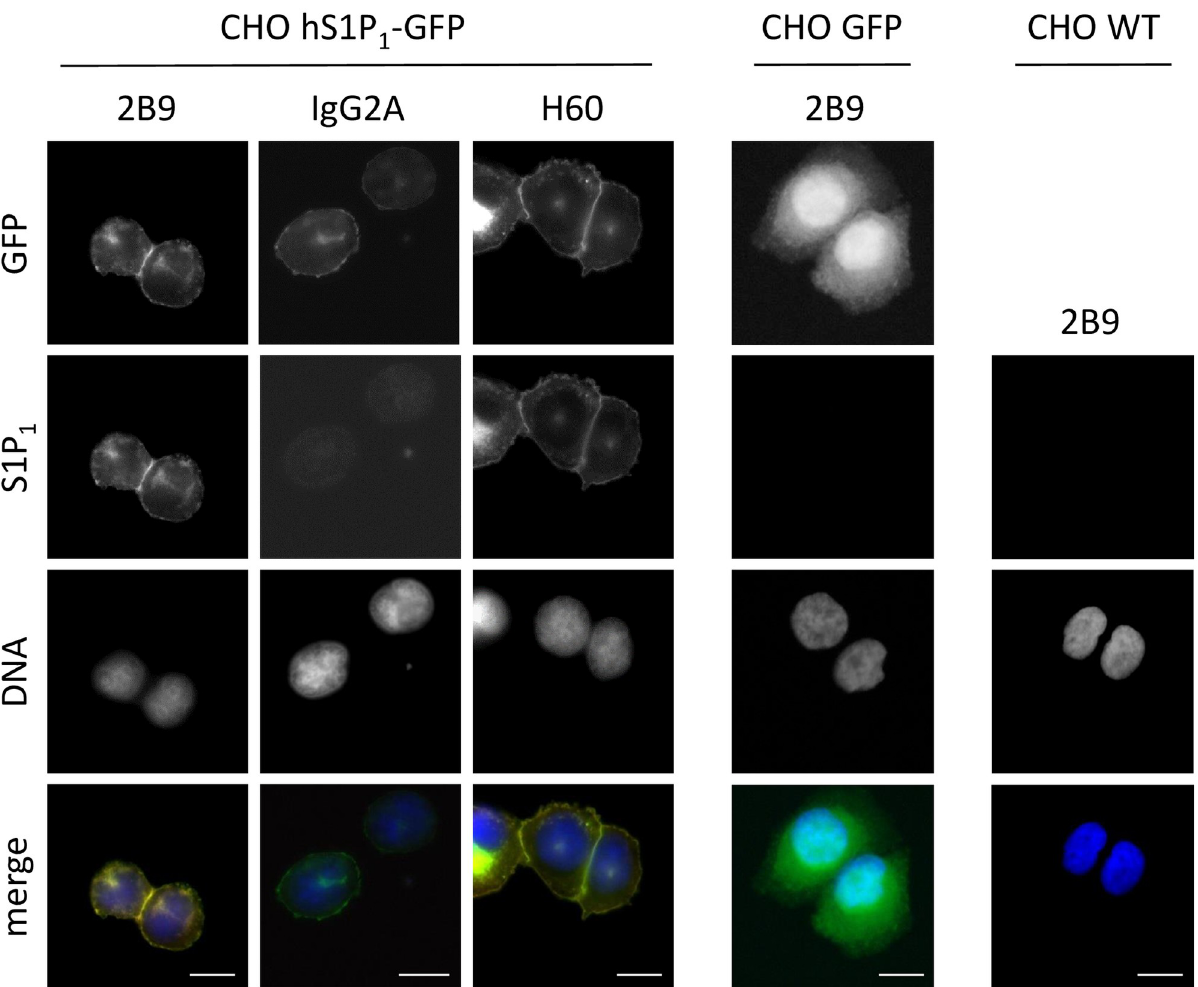
Fig 4. 2B9 specifically recognizes recombinant S1P 1 . CHO cells stably expressing hS1P 1 (CHO hS1P 1 -GFP) or GFP (CHO GFP) and CHO WT cell lines were seeded on coverslips and 24h later were fixed and stained for S1P 1 (red) with 2B9 or H60 or control IgG2A antibodies (1:100, w/v). Cells were treated with DAPI to visualize nuclei (blue). Colocalization (yellow) is shown between GFP (green) and 2B9 (red). Images are representative of the population examined. Scale bar, 10 μ m.